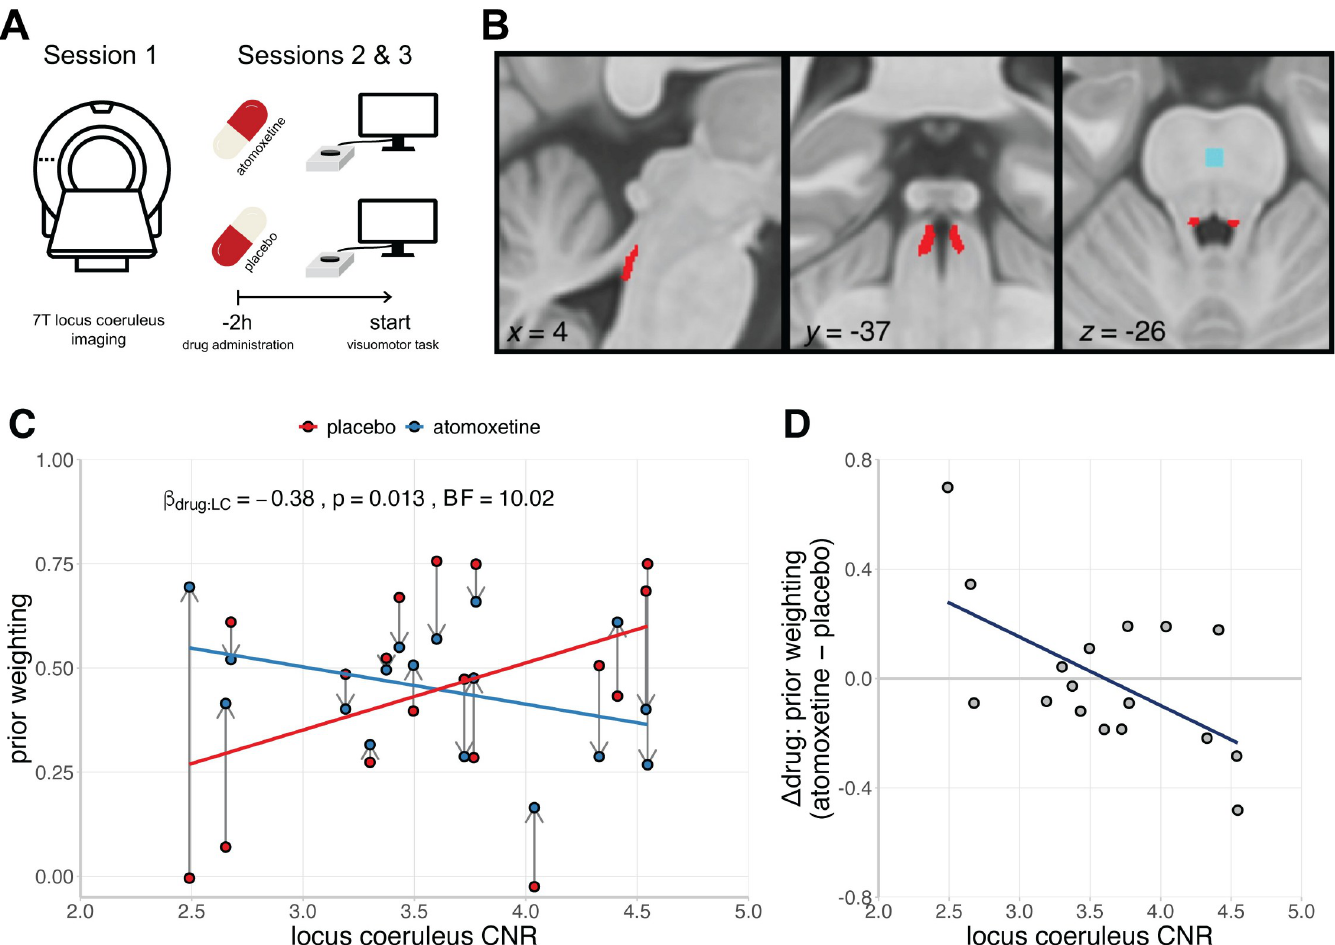
Fig 3. Baseline-dependent effects of noradrenaline on prior weighting. A) Schematic overview of the noradrenergic drug study. The first session involved 7T MRI of the locus coeruleus, to estimate the mean contrast-to-noise ratio (CNR). The second and third sessions formed a double-blind randomised placebo-controlled crossover study, with 40 mg of oral atomoxetine of placebo. Two hours after drug administration, participants performed the visuomotor task that was designed to estimate prior weighting. B) Study-specific independent locus coeruleus atlas (red) and reference region in the central pons (blue). Image reused from O’Callaghan et al. [62] under a CC-BY 4.0 license (https://creativecommons.org/licenses/by/4.0/). C) Estimates of prior weighting for participants with Parkinson’s disease, plotted as a function of their locus coeruleus CNR and the drug condition. Within-subject change in prior weighting from placebo to atomoxetine is indicated by the grey arrows. D) The relationship between the drug-induced change in prior weighting (atomoxetine minus placebo) and locus coeruleus CNR. https://doi.org/10.1371/journal.pcbi.1010079.g003 (atomoxetine vs. placebo) was negatively associated with locus coeruleus CNR, such that par- ticipants with lower locus coeruleus CNR tended to have a more positive change in prior weighting (Fig 3D; r = -0.59, p = .013; BF = 5.13). There were no main effects of the drug (15) condition ( β = -2.06 × 10 − 3 , SE = 0.13, F = 2.36 × 10 − 4 , p = .988; BF = 0.29) or locus coeru- (1, 15) = 0.16, p = .695; BF = 0.43) on prior weighting. leus CNR ( β = -0.08, SE = 0.20, F (1, 14) Supplementary analyses confirmed the robustness and specificity of the interaction effect between the drug condition and locus coeruleus CNR. First, using both frequentist and Bayes- ian model selection procedures, we found that this interaction persisted with additional covari- ates, including age, motor severity (UPDRS part III), levodopa equivalent daily dose, atomoxetine plasma level, and total intracranial volume (S2 Text). Second, we used a linear mixed effects model with CNR extracted from the substantia nigra, as a neuromelanin-rich control region [63]. There was no interaction effect between the drug condition and substantia